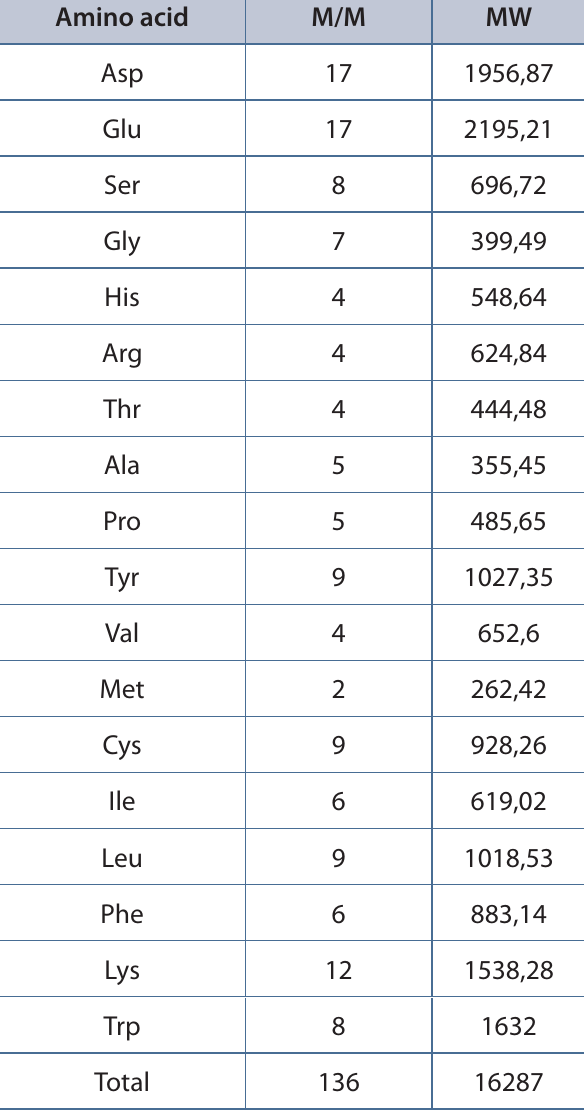
Table 1. Amino acid analysis of Bothrops moojeni venom determined by Pico-Tag ® amino acid analyzer